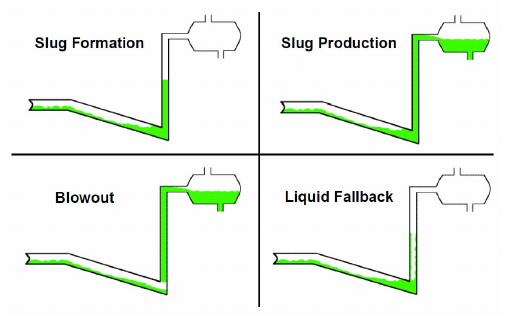
Figure 1: Schematics of the severe slug cycle in flowline riser systems Pickering et al.